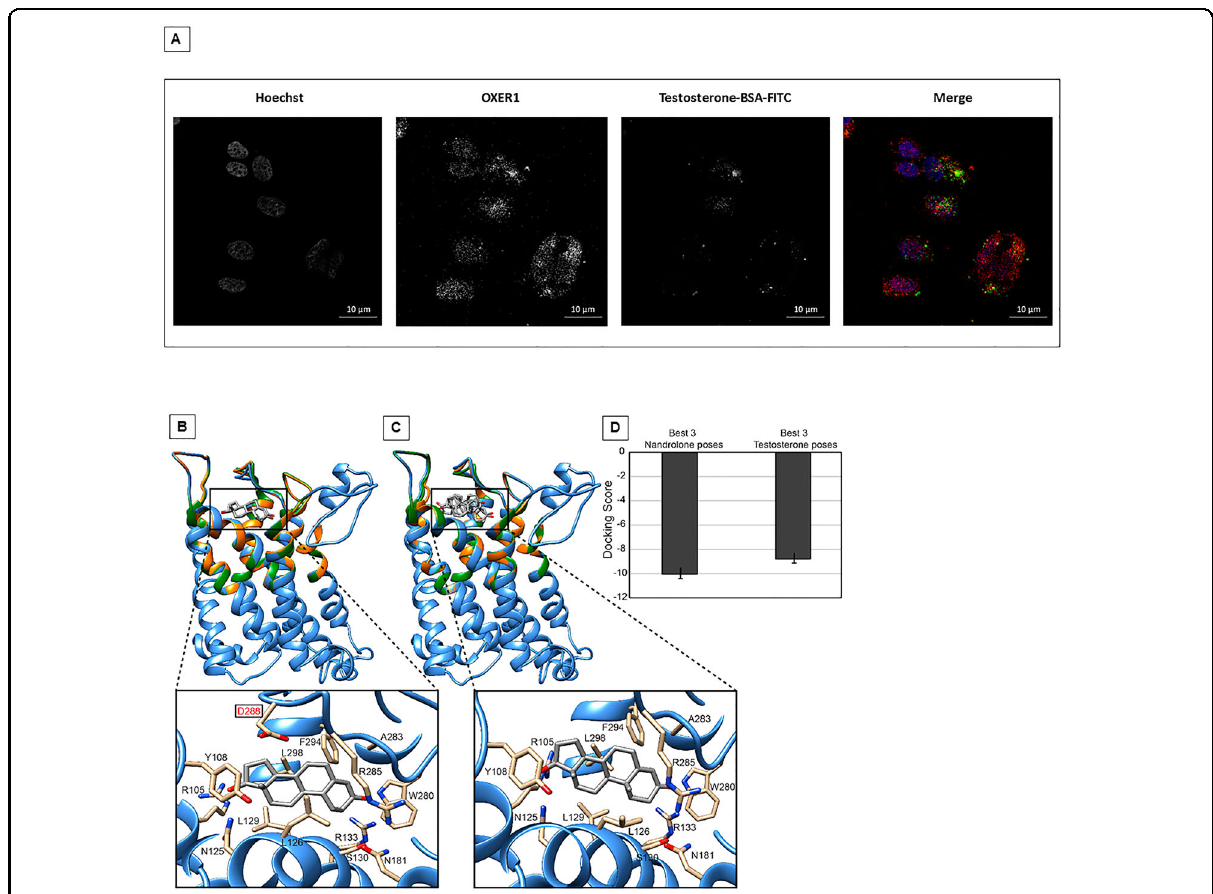
Fig. 4 Structural model of OXER1 and molecular docking with nandrolone and testosterone. A Interaction between OXER1 and testosterone- BSA FITC in MCF7 cells. Acquisition by confocal microscope SP5 (for details see materials and methods). B – C Ribbon representation of the structural model of OXER1. The region of the receptor deputed to interact with the nandrolone or testosterone and considered fl exible along the docking calculations is colored in orange and green respectively. For both molecules the 10 best docking poses are shown, while the insets report only the best one. D Mean value of the docking score for nandrolone and testosterone calculated on the best three